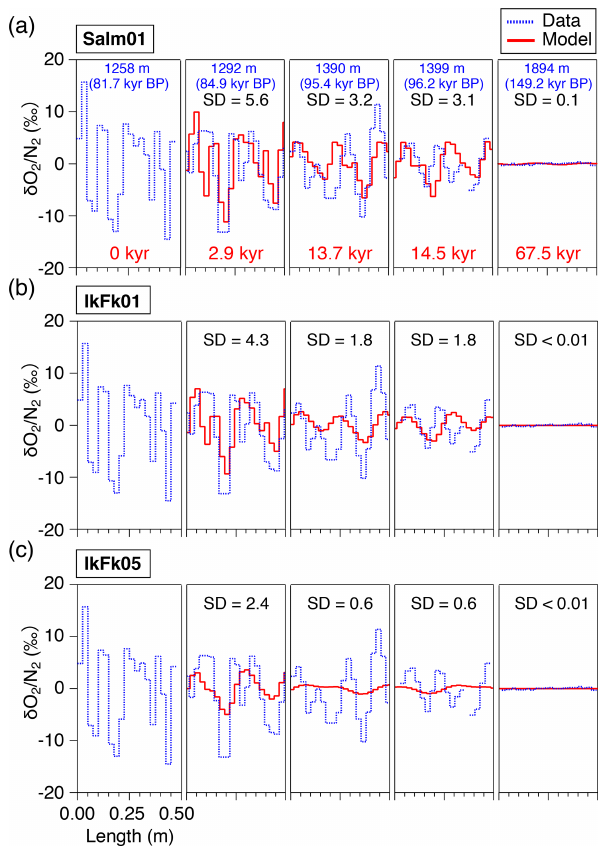
Figure 8. Comparison of the diffusion model outputs for δ O 2 / N 2 with different permeation parameters (red lines) and high-resolution data (dotted blue lines), at 1292, 1390, 1399, and 1894m. The data at 1258m were given to the diffusion model as the initial condition. Solid lines (red) are the model outputs at the elapsed time of 2.9, 13.7, 14.5, and 67.5kyr, resampled at 2.5cm intervals, to compare with the corresponding high-resolution data. SDs of the model re- sults are shown in each panel.